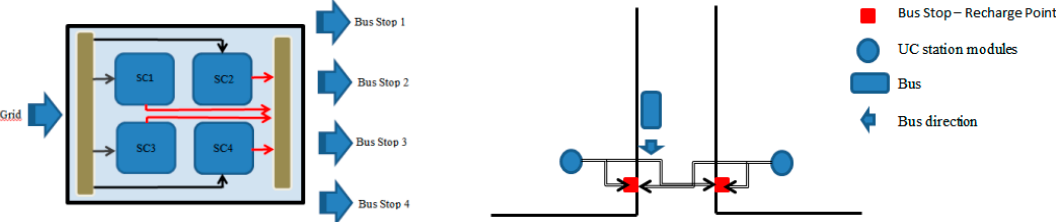
Figure 10. Proposed structure for the flash charging network.